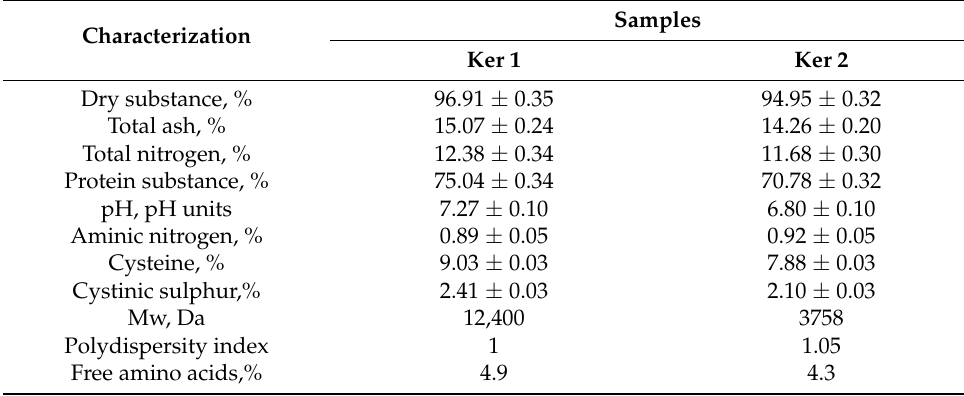
Table 1. Physical-chemical characteristics of lyophilized keratin hydrolysates.